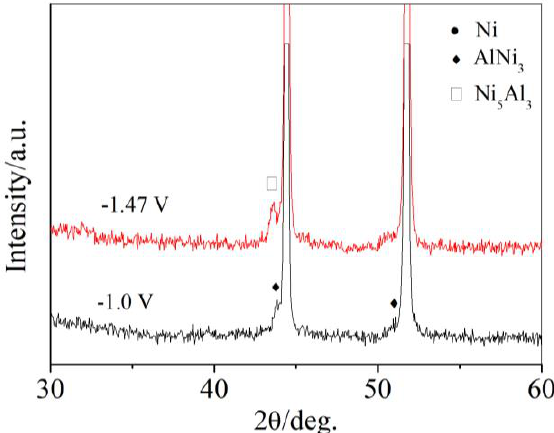
Figure 7. XRD of samples obtained by potentiostatic electrolysis on Ni plate at different potentials from LiCl-KCl-AlCl 3 (2 wt.%) melts at 703 K.